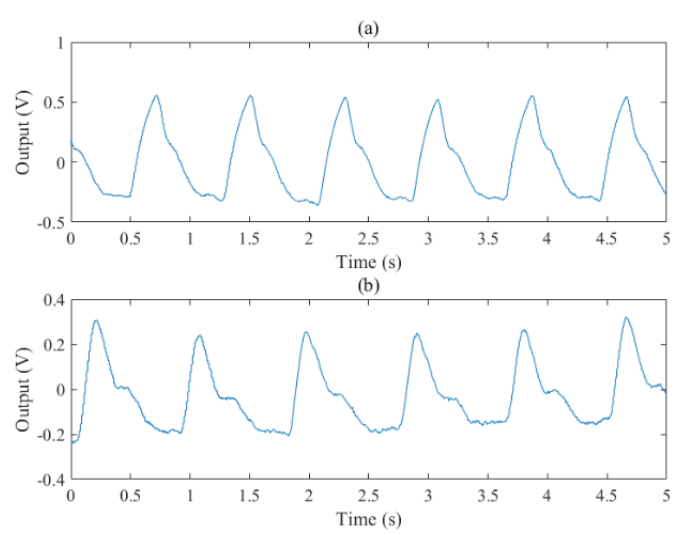
Figure 16. The output PPG signal with a large input photocurrent when the AGC is off ( a ) and on ( b ).